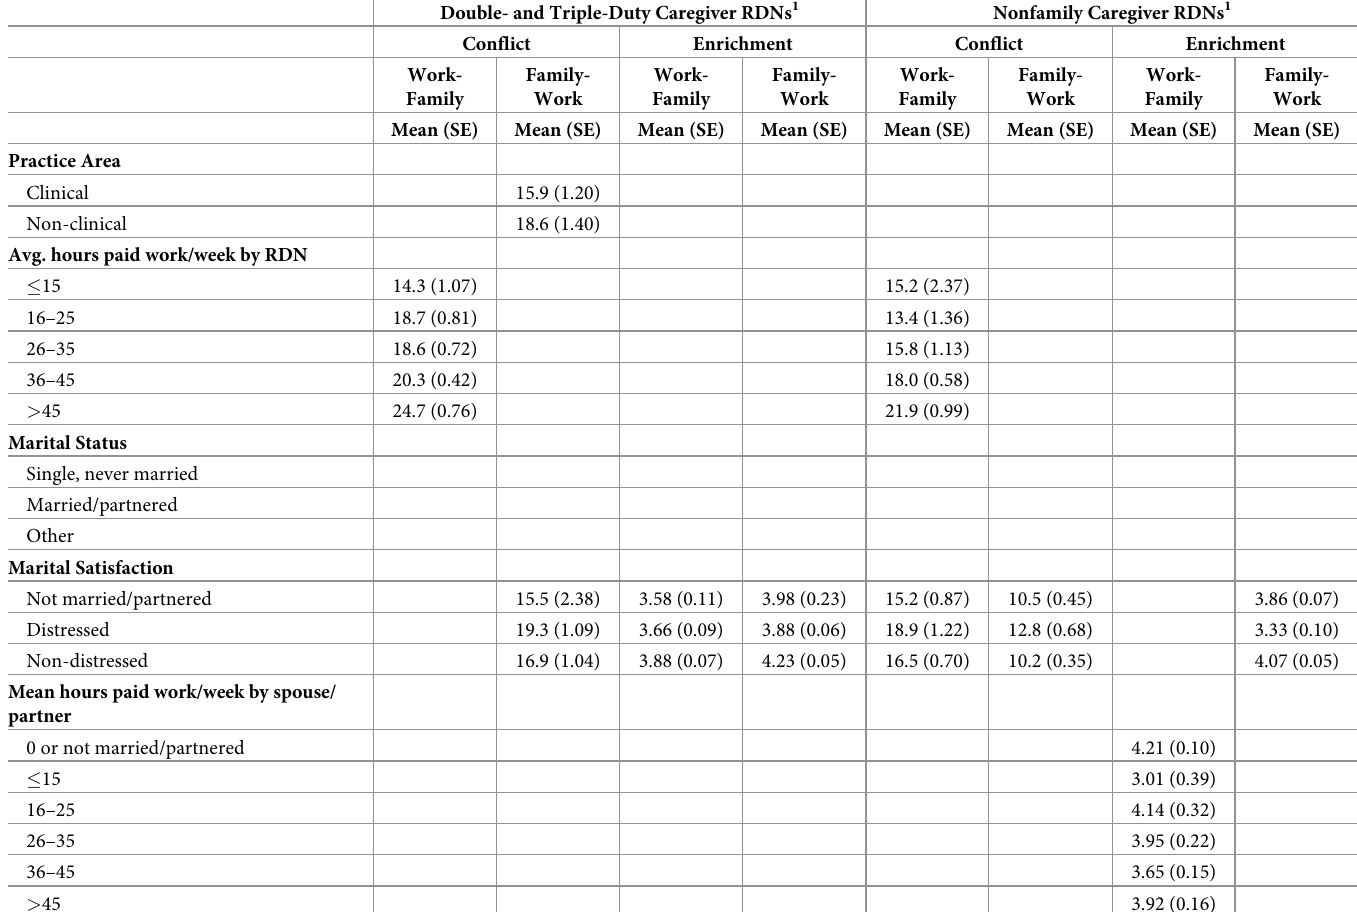
Table 3. Means and Standard Errors (SE) of statistically significant variables with work-family scores based on caregiving